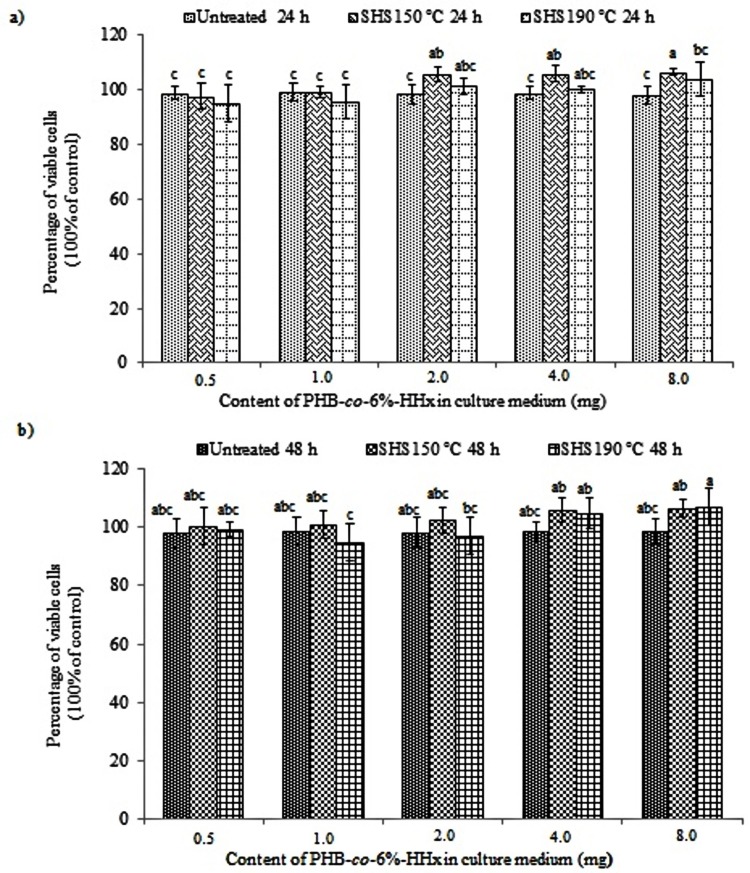
Cell viability of NIH 3T3 cells incubated with untreated and SHS-treated P(HB-co-6%-HHx) samples.(a) Cell cultured for 24 and (b) 48 h. The mean data denoted by different superscript letters are significantly different (Duncan’s multiple range test, p < 0.05).